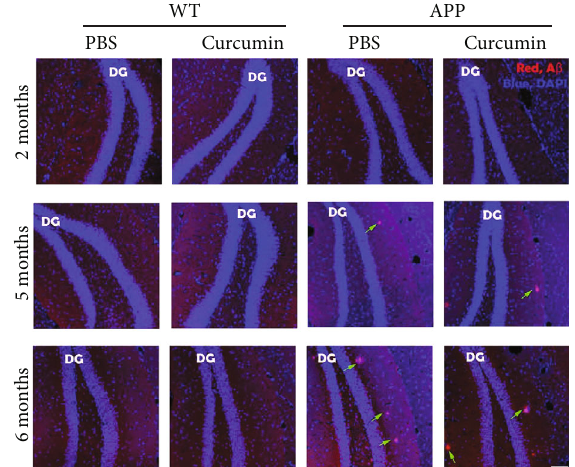
Figure 2: A β immunohistochemistry of hippocampus (red, A β ; blue, DAPI). WT control brain exhibited no plaques in each group of age, while plaques of APP mice aged 5 and 6 months began to accumulate (green arrows). Abbreviations: APP: APPswe/PS1dE9; WT: wild type. Scale bar = 100 μ m